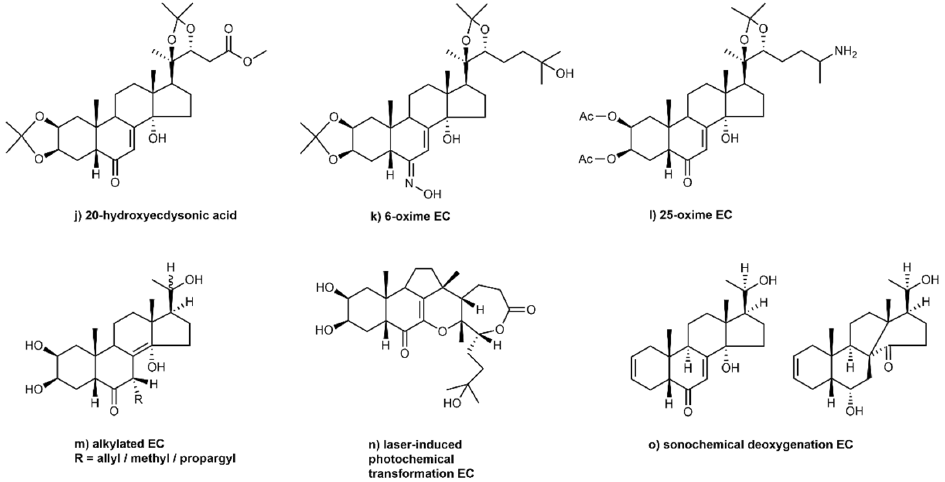
Figure 2. Structural modifications of ccdysteroids via etherification, esterification, oxidation, ami- nation, fluorination, and alkylation.